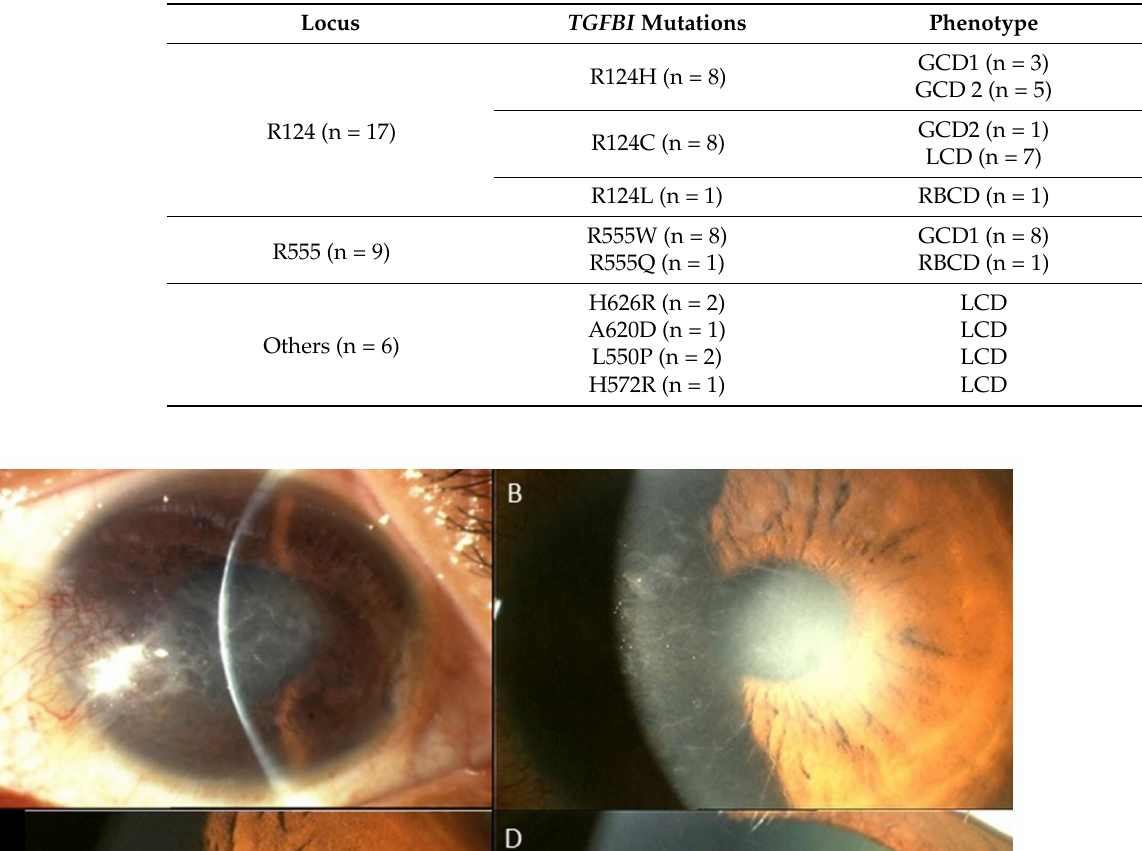
Table 4. The distribution of phenotypes of TGFBI corneal dystrophies in each genotype of TGFBI mutations.